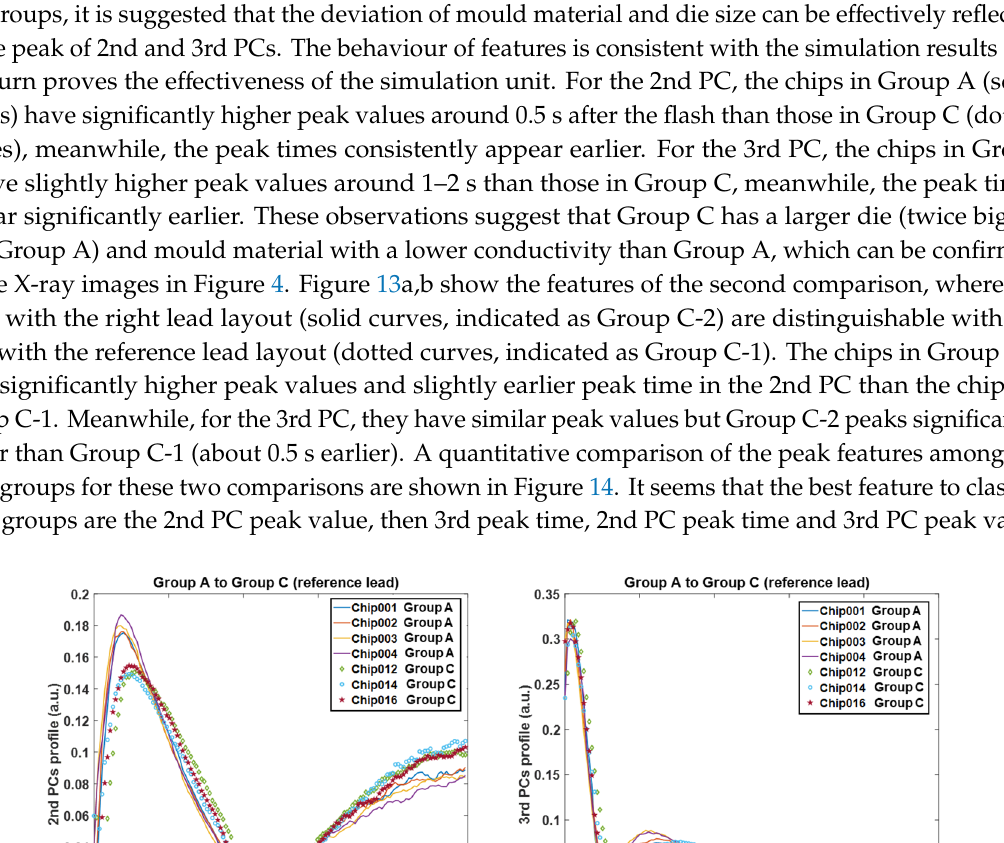
( b ) Figure 13. Feature results of the 2nd verification comparison; ( a ) the 2nd principal component profiles; ( b ) the 3rd principal component profiles.